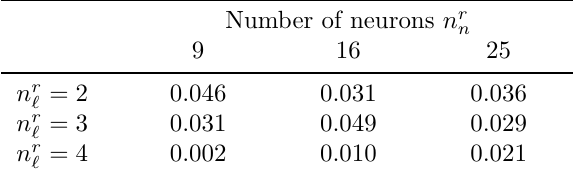
Table 1. Values of the volume fraction error ε φ , depending on the number of layers n r and the number ‘ of neurons in each layer n r n .